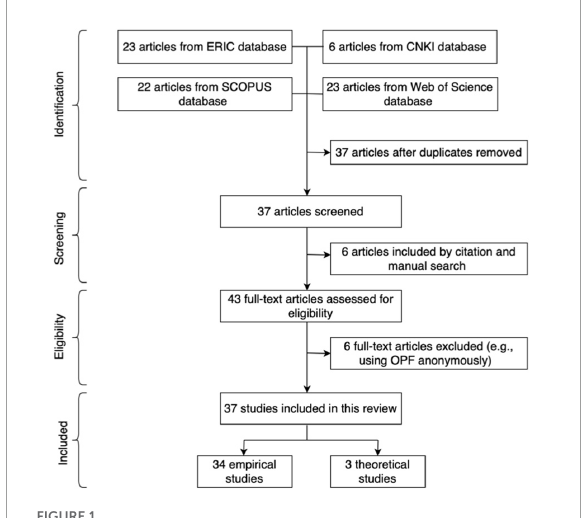
FIGURE1 Screening process of the reviewed